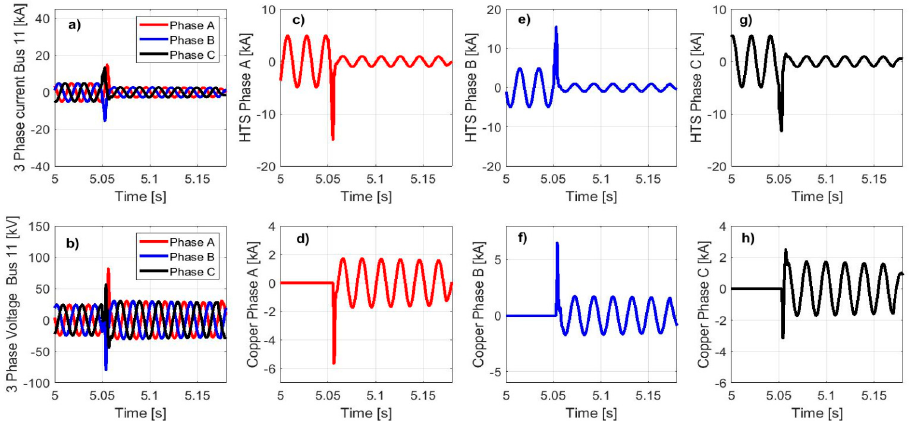
Figure 8. Fault current and voltage signatures for 3-Phase-to-ground solid fault at 50% of cable’s length.: ( a ) phase currents at Bus 11, ( b ) phase voltages at Bus 11, ( c ) current in HTS layer of phase A, ( d ) current in copper layer of phase A, ( e ) current in HTS layer of phase B, ( f) current in copper layer of phase B, ( g ) current in HTS layer of phase C, ( h ) current in copper layer of phase C.